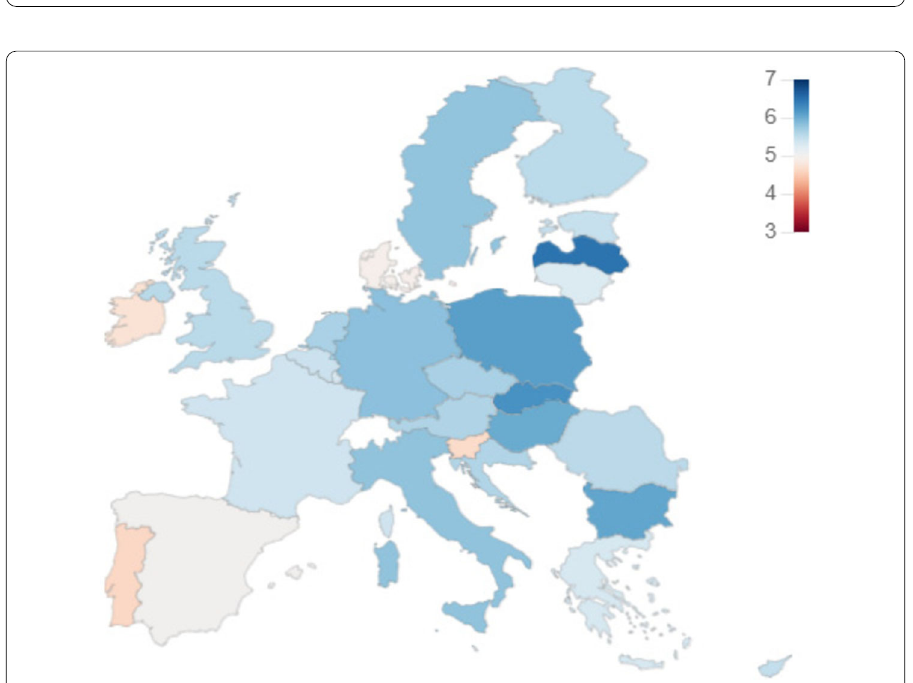
Figure 9 Political positions of European Countries